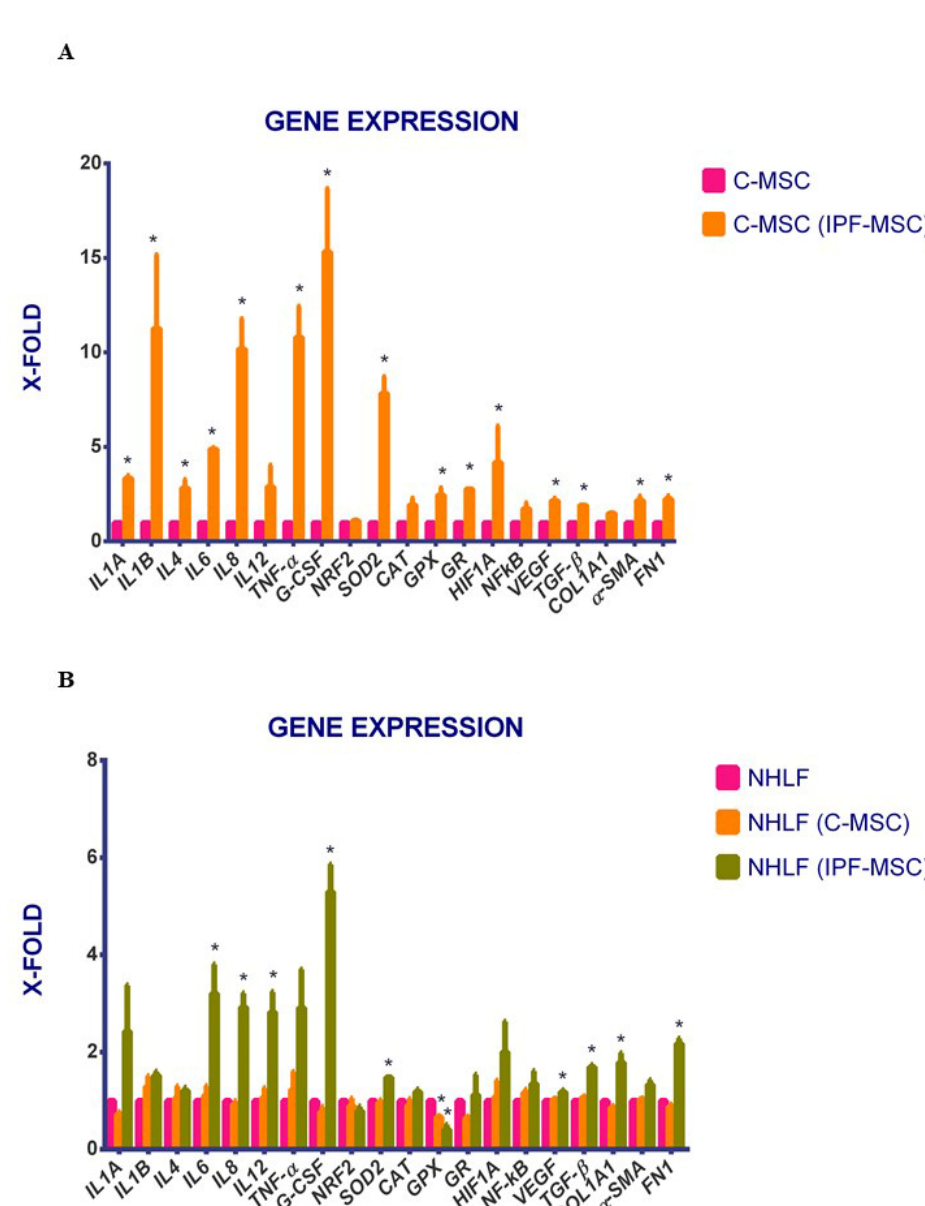
Figure 6. Gene expression after co-cultures. The histogram displays the expression of selected genes referred specifically to inflammation ( IL1A , IL1B , IL4 , IL6 , IL8 , IL12 , TNF- α , and G-CSF ) and to other related pathways such as hypoxia ( HIF1A , NFkB, and VEGF ), oxidative stress ( SOD2 , CAT , GPX , GR, and NRF2 ) and ECM pathway ( TGF- β 1 , COL1A1 , α -SMA, and FN1 ) after co-culture between C- and IPF-MSC ( A ). Levels of expression detected in C-MSC(IPF-MSC) is referred to as X-fold with respect to C-MSC (express as 1). The figure ( B ) shows the expression of the selected genes on NHLF before and after co-culturing with C-and IPF-MSCs. Levels of expression detected in NHLF(C-MSC) and in NHLF(IPF-MSC) are referred to as X-fold with respect to NHLF (express as 1). Data are mean ± SD, over three independent experiments. The * indicate significative di ff erences referred to as C-MSC (one-way ANOVA; p < 0.05). C-MSCs: mesenchymal stem cells (MSCs) from controls cultured alone; C-MSC (IPF-MSCs): C-MSCs after 72 h of co-culture with IPF; NHLF: NHLF cultured alone;